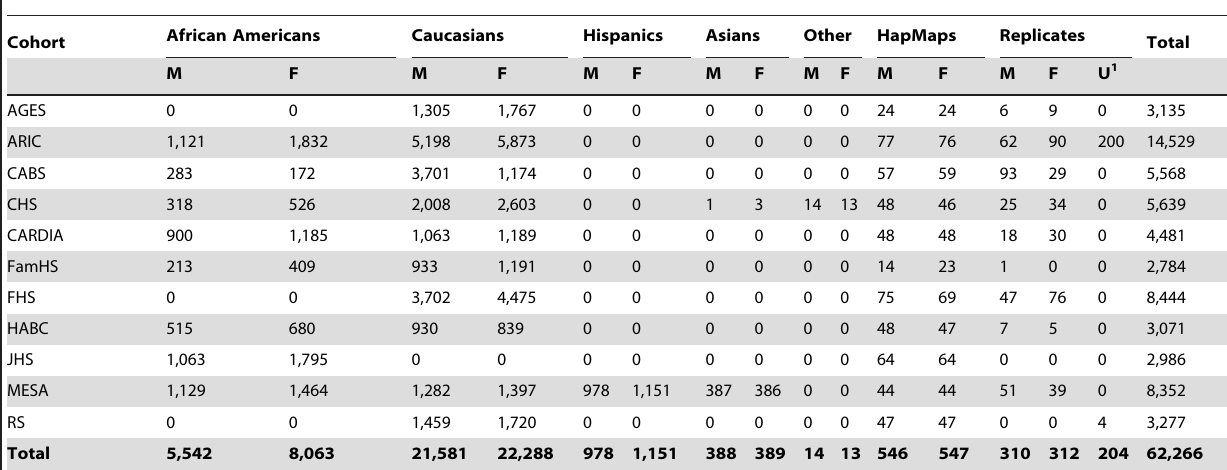
Table 3. Sample sizes of cohorts participating in joint calling effort by gender and self-reported